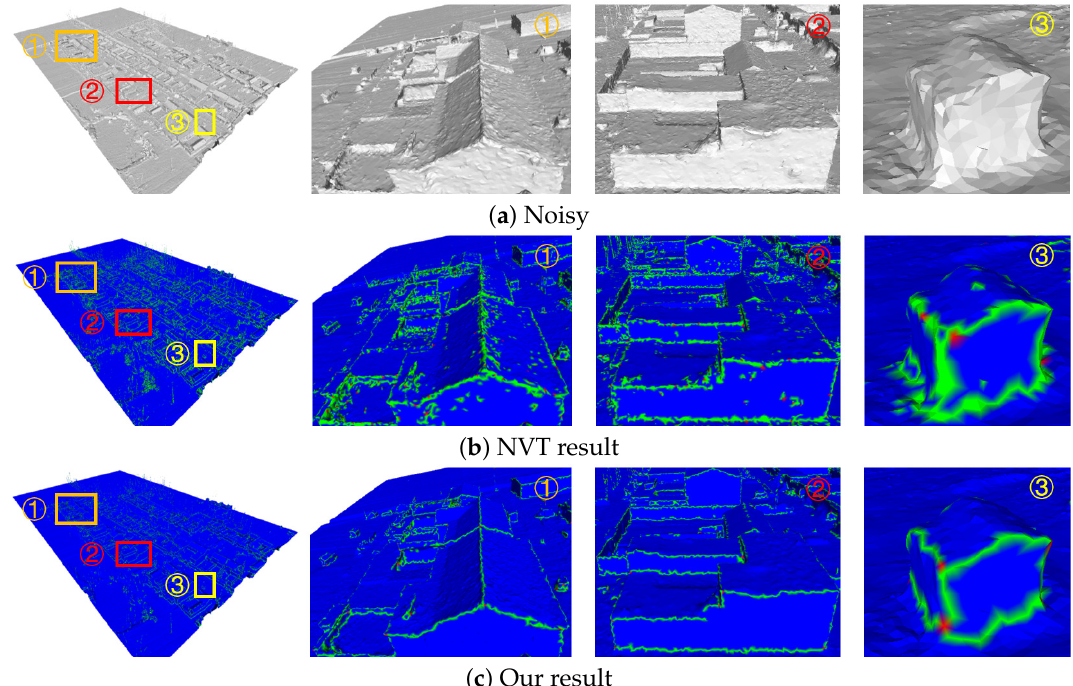
Figure 13. Comparison of feature point classification results for the Village model reconstructed from oblique